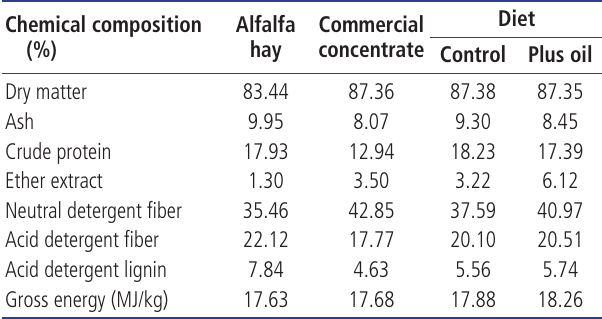
Table 1. Chemical composition (dry matter basis, n = 3) of the alfalfa hay, commercial concentrate and experimental diets without (control) and with oil supplement (Plus